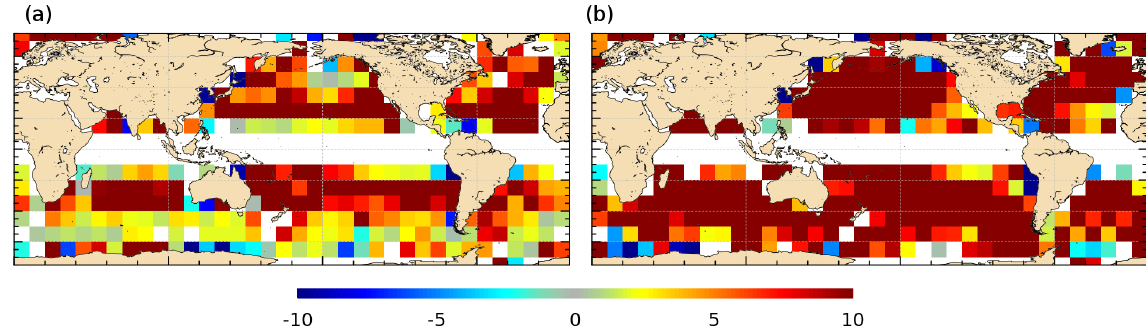
Figure 2. Difference (cms − 1 ) of the RMSD obtained using the first guess of MDT CNES-CLS13 and the first guess of MDT CNES_CLS18 for the (a) zonal and (b) meridional components in 5 ◦ × 5 ◦ boxes. Only boxes with more than 500 points and where difference is statistically significant at more than 95% ( T test) are shown. The reddish colors denote improvement while bluish colors stand for degradation (see text for more